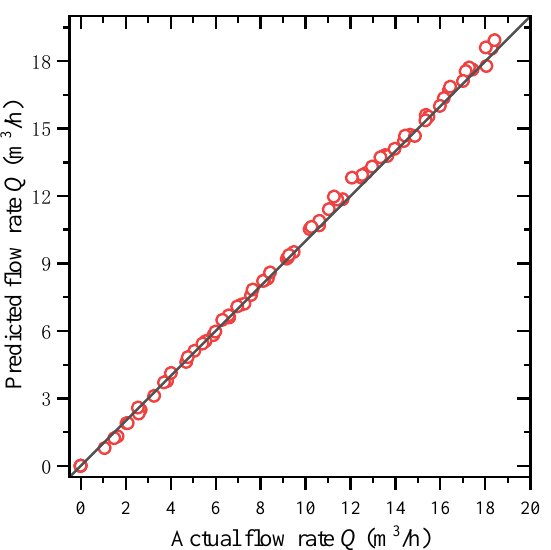
Figure 15. Results of flow estimation.